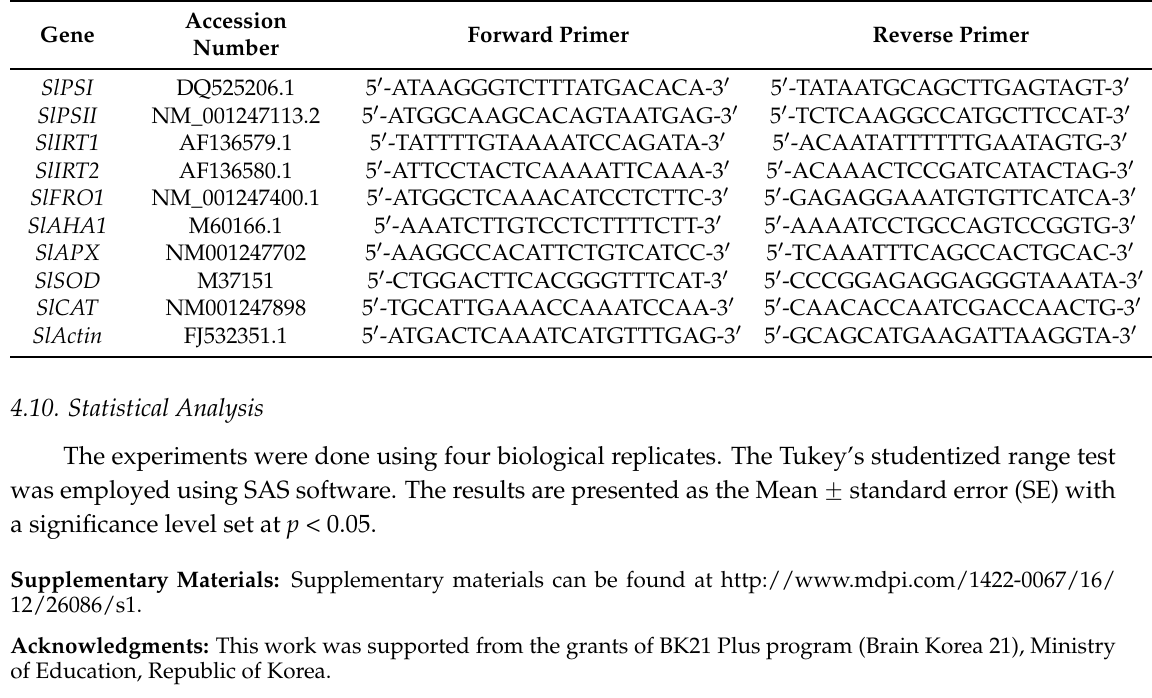
Table 1. List of primers used to quantify gene expression